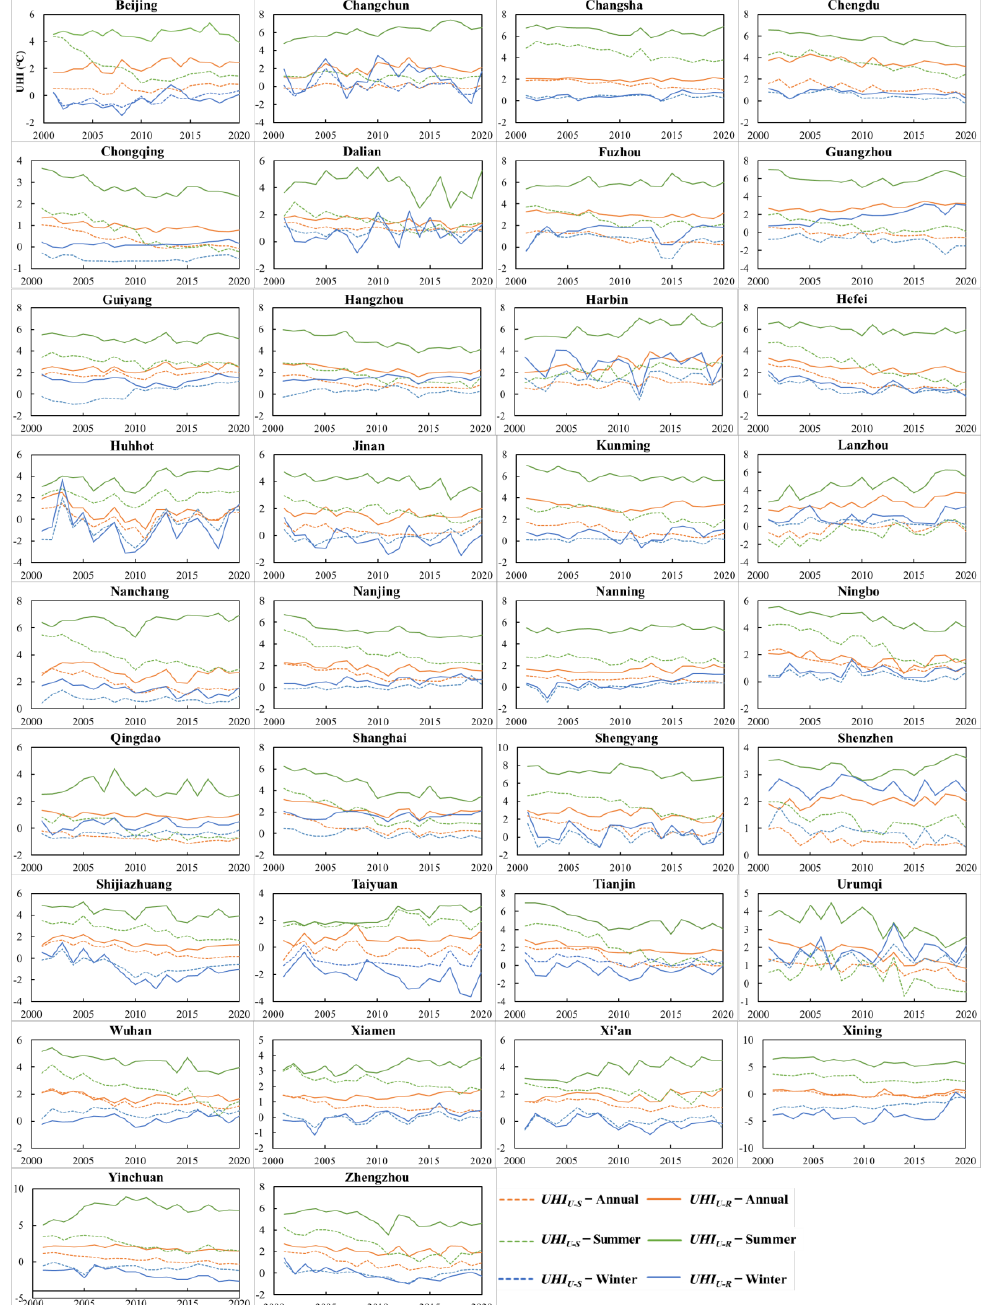
Figure 7. Temporal variations (annual, summertime, and wintertime) in 𝑈𝐻𝐼 𝑈−𝑆 and 𝑈𝐻𝐼 𝑈−𝑅 in 34 cities from 2001 to 2020. The solid and dashed lines represent 𝑈𝐻𝐼 𝑈−𝑅 and 𝑈𝐻𝐼 𝑈−𝑆 , respectively. Red, green, and blue colors represent annual, summertime, and wintertime results, respectively. Figure 8(a1 – c1,a2 – c2) show the temporal variations in 𝑈𝐻𝐼 𝑈−𝑆 and 𝑈𝐻𝐼 𝑈−𝑅 of cities with different topographies from 2001 to 2020. Both 𝑈𝐻𝐼 𝑈−𝑆 and 𝑈𝐻𝐼 𝑈−𝑅 changed more sig- nificantly in summer than in winter for the different types of cities. The variations in 𝑈𝐻𝐼 𝑈−𝑆 and 𝑈𝐻𝐼 𝑈−𝑅 of mountain cities differed from the other cities. Specifically, especially in sum- mer, the 𝑈𝐻𝐼 𝑈−𝑆 of mountain cities decreased more slowly (SloFL = − 0.04) than those of